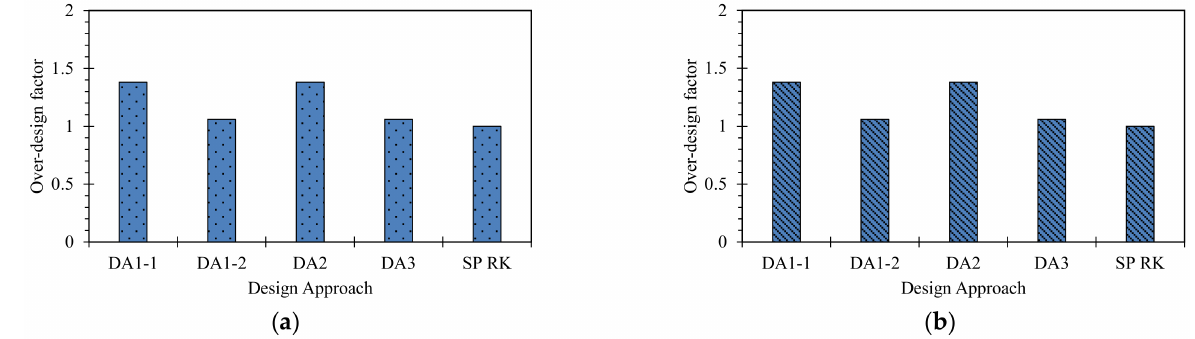
Figure 4. Over-design factors of the ( a ) raft foundation and ( b ) pile